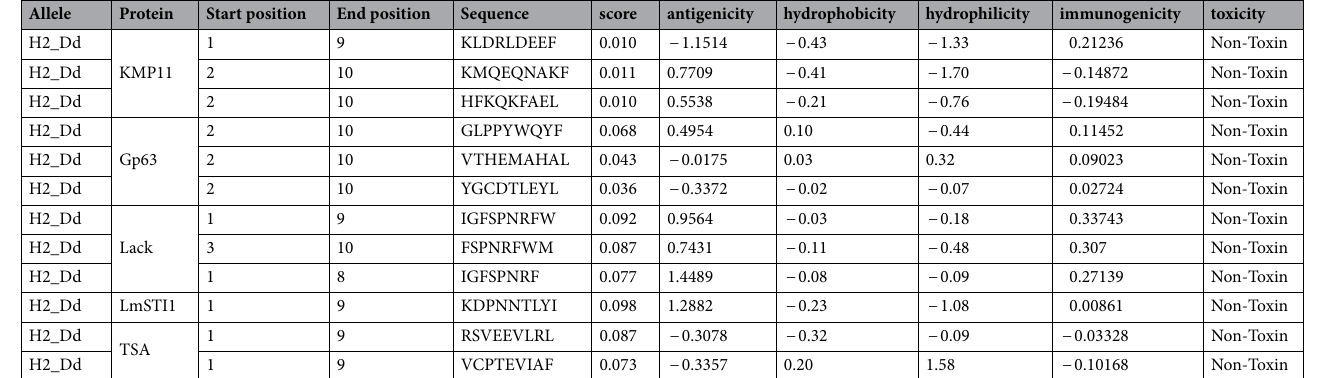
Table 1. Predicted epitopes for KMP11, Gp63, Lack, LmSTI1 and TSA. They selected based on the (IEDB) server.